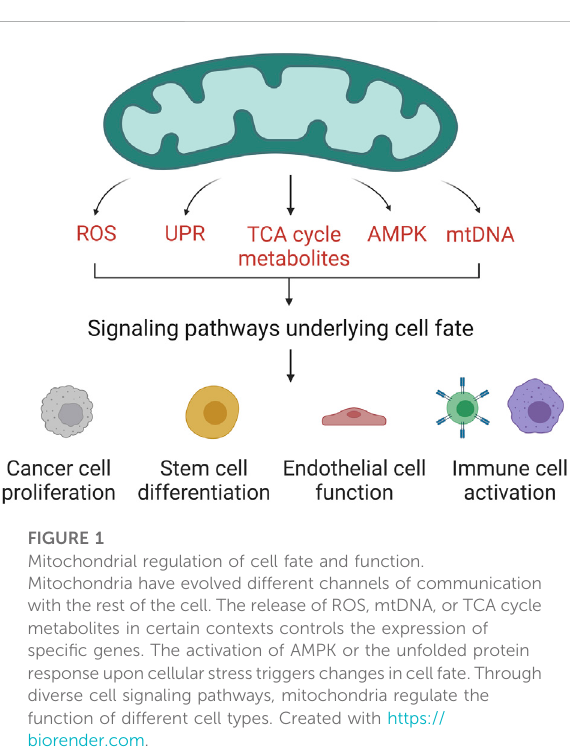
FIGURE 1 Mitochondrial regulation of cell fate and